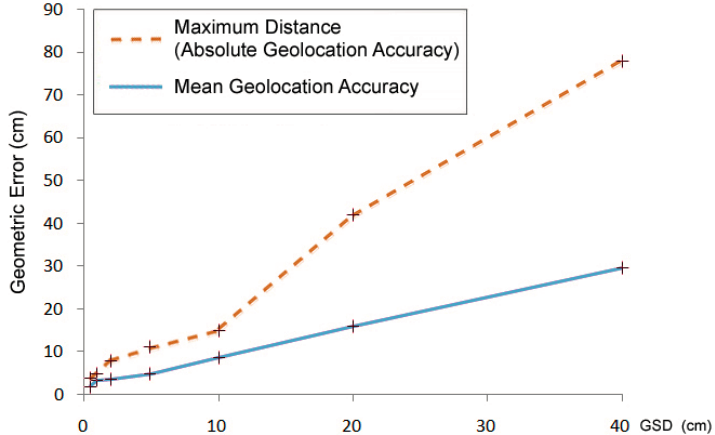
Figure 2. Absolute geometric accuracy of different-resolution ortho image mosaics expressed in cm.